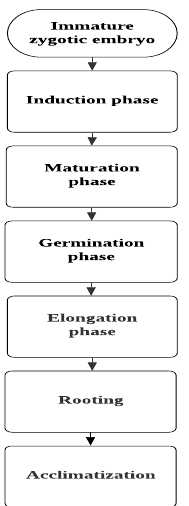
Figure 1. General phases in somatic embryogenesis process.